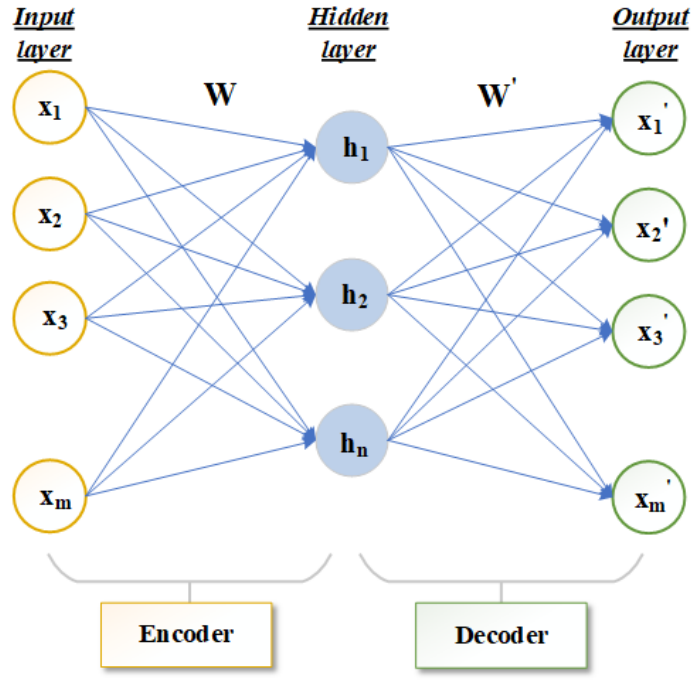
Figure 1. Structure diagram of autoencoder